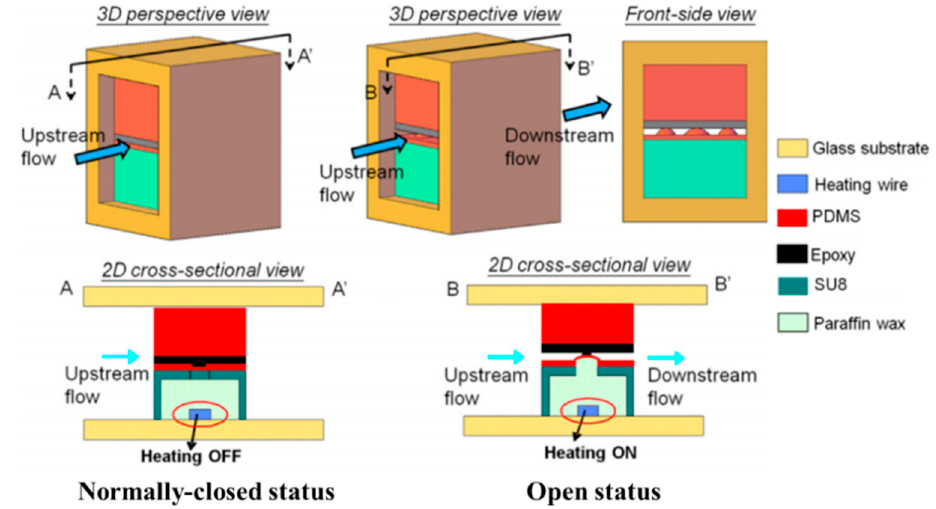
Figure 16. Working principle of the paraffin microvalve [102].